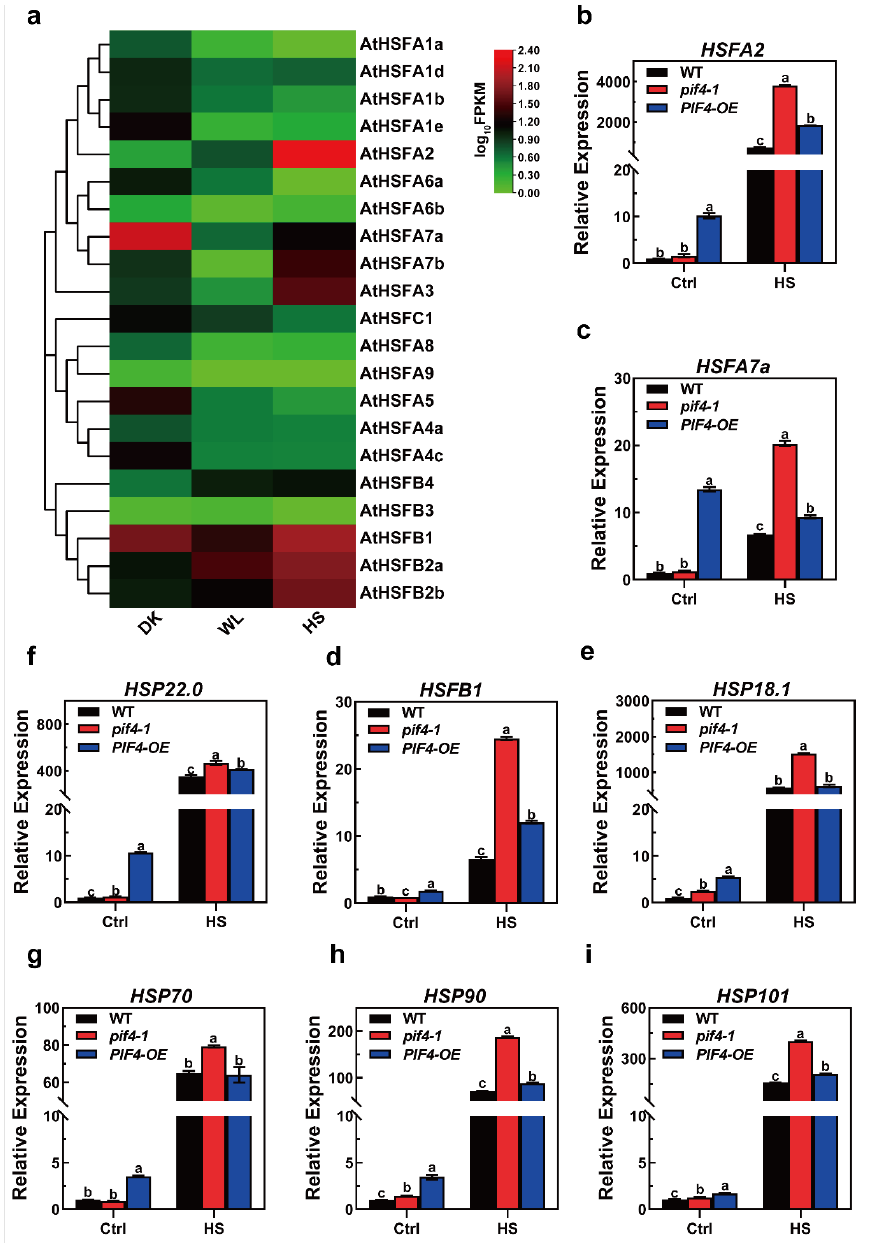
Figure 7. The expression patterns of heat stress (HS)-inducible genes under severe heat stress conditions. ( a ) Heat maps of the expression of the AtHSF genes in 7-day-old WT seedlings under DK,